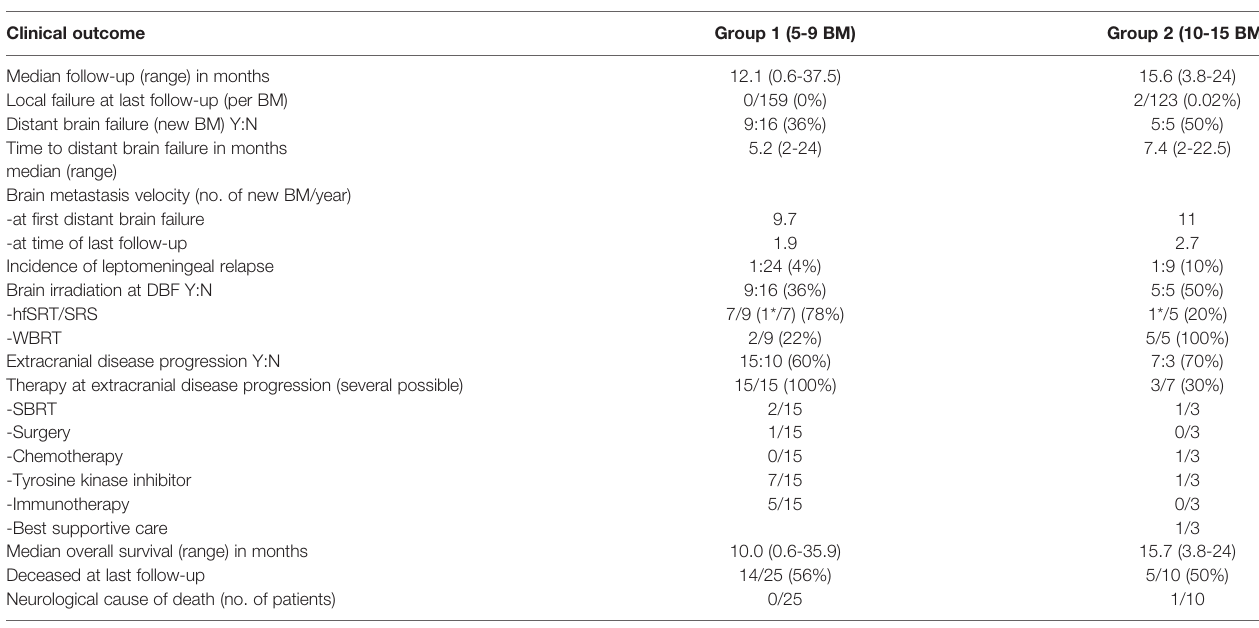
TABLE 3 | Clinical outcomes following SRS.